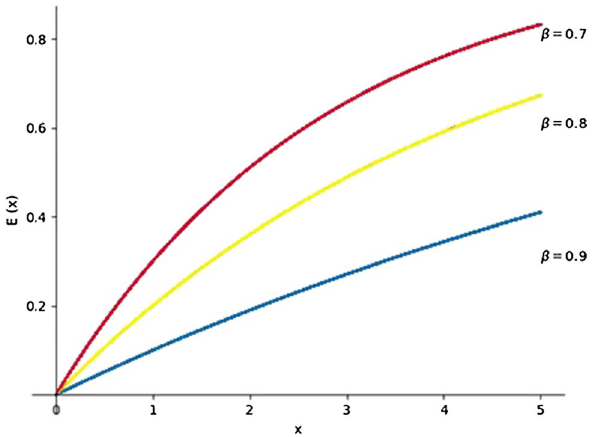
Fig. 3 Graphic illustration of the elation